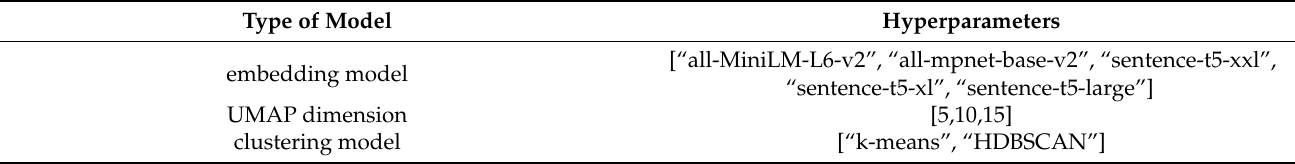
Table 7. Experimental setup for